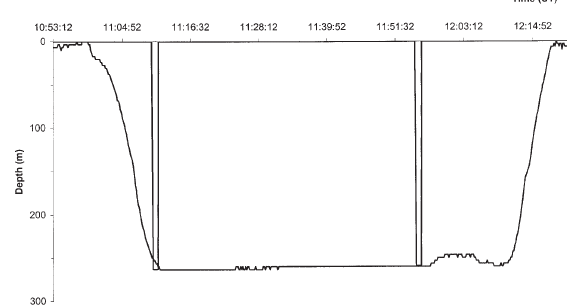
F IG . 7. – A standard trawl vertical trajectory of the gear in relation with time (on the main curve; the sharp lines indicate the official in Fig. 2 - and end - t in Fig. 2 - of haul as well as the depth start - t 4 5 recorded by the bridge sounder at this moment; “ Nautilos ”